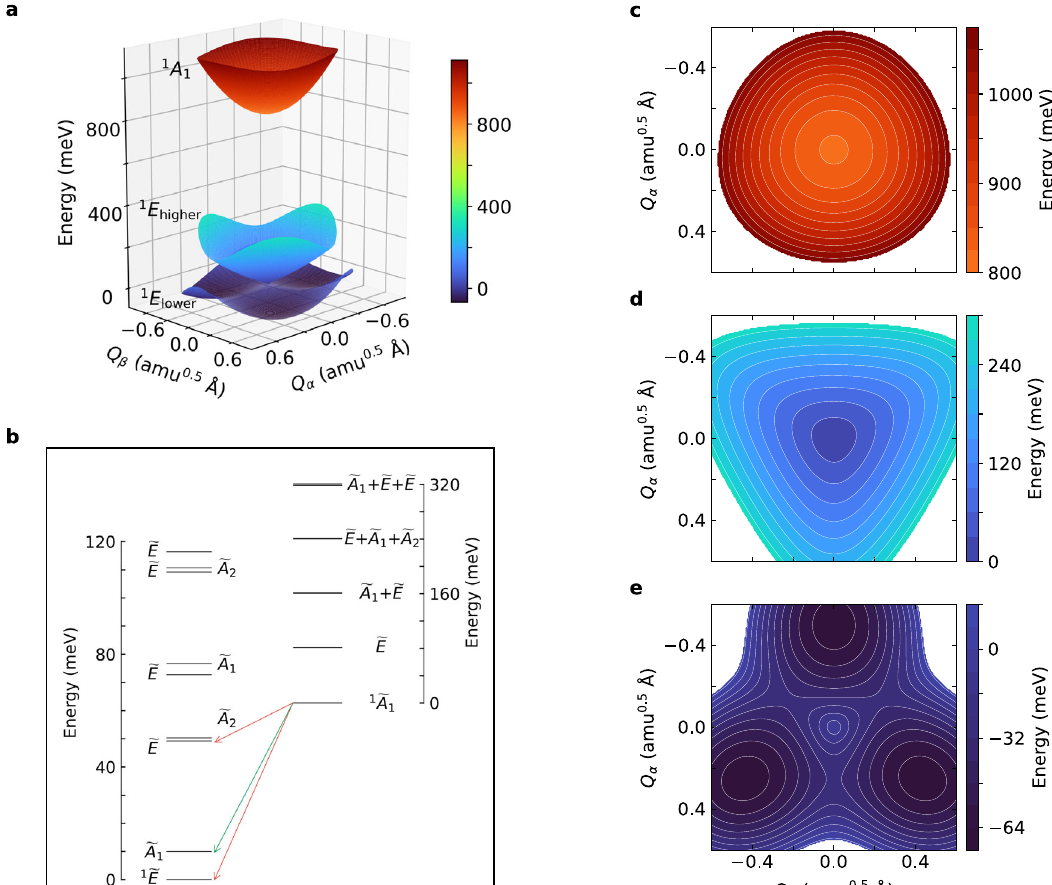
Fig. 4 Potential energy surfaces (PESs) and vibronic energy levels of the many-body electronic states of the NV − center in diamond. a Adiabatic PESs of the lower and higher branches of the 1 E and 1 A 1 states. The Q α , Q β con fi guration coordinates (see text) represent the collective motion of effective phonon modes with e symmetry. Contour plots of the PESs are shown in c – e . The PES of the 1 E lower branch ( e ) has the “ tricorn Mexican hat ” shape with three minima and three saddle points, and is connected to the higher branch ( d ) through a cusp. The PES of the 1 A 1 singlet ( c ) slightly deviates from a perfect two-dimensional paraboloid. b The vibronic levels of the 1 E (left) and 1 A 1 (right) states, whose vibronic ground states are labeled as 1 e E and 1 e A 1 , respectively. The energy differences of vibronic levels of the 1 A 1 from bottom to top are found to be 80.8, 79.7, 78.8, and 77.3 meV, respectively. The selection rules for the photoluminescence (PL) are indicated as arrows: red arrows represent the optically active 1 e A 1 ! 1 e E transition resulting in the zero-phonon line (ZPL) and the 1 e A 1 ! e E transition resulting in the phonon side band shifted by 49.3 meV from the ZPL; the green arrow represents the 1 e A 1 ! e A 1 transition, shifted by 10.0 meV from the ZPL, and can be activated by uniaxial stress. In the plot, the values of the ZPL and side bands are not given on the same energy scale for